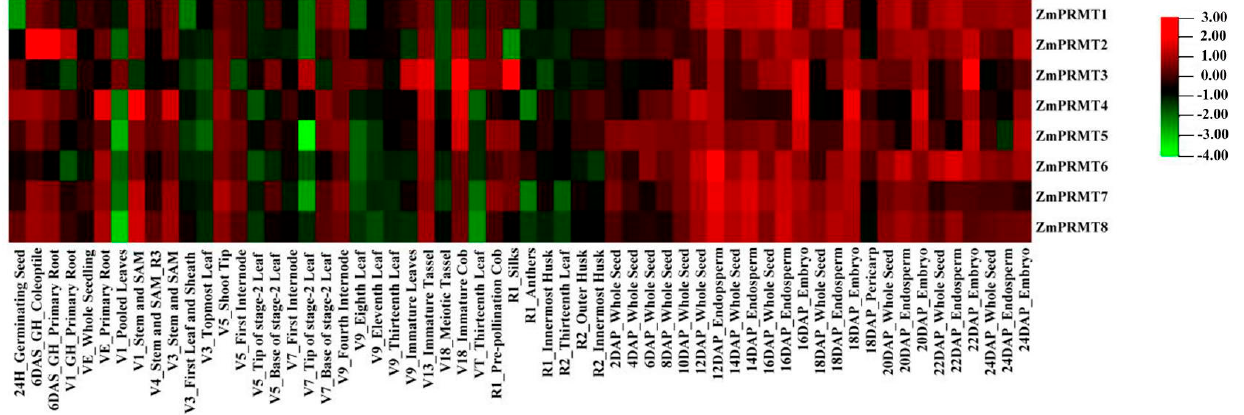
Figure 4. Hierarchical cluster analysis of expression profiles of 8 maize ZmPRMT genes. Hierarchical cluster analysis of expression profiles of ZmPRMT genes family in all 60 tissues that including the whole growth and development process of maize. The color code on the right indicates the log2 signal value. The gene name of each ZmPRMT is shown on the left of each line. Red represents a high level and green indicates a low level of transcript abundance. The tissues and/or organs in different development periods are noted on the bottom of each lane.